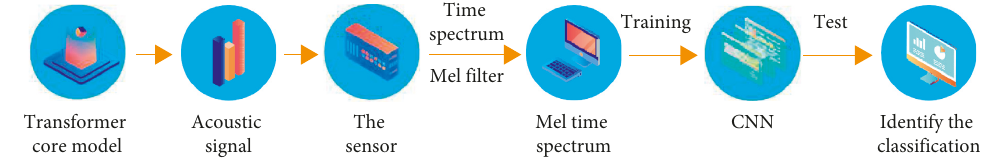
Figure 3: Structure diagram of the Mel time spectrum-CNN vowel recognition